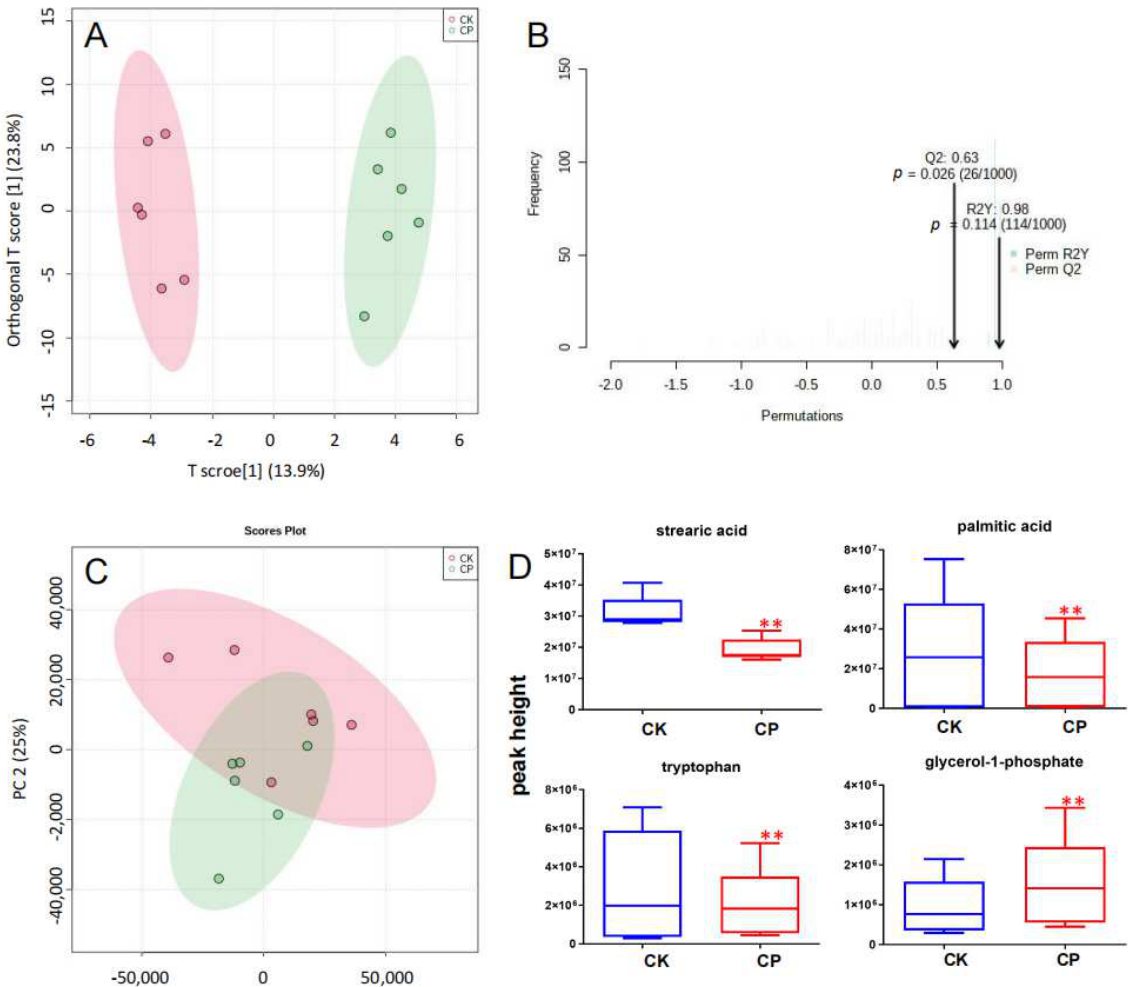
Figure 7. Metabolic profile and differential metabolites of polar substances in the amniotic fluid using GC-MS. ( A , B ) OPLS-DA score plots of the amniotic fluid metabolite profile and validation of OPLS-DA models with 1000 permutation tests ( n = 6). ( C ) PCA score plots of the amniotic fluid metabolite profile ( n = 6). ( D ) Normalized peak intensity of amniotic fluid metabolites differentially expressed in pregnant rats receiving CP ( n = 6). Each data point represents the mean ± S.E.M. ** p < 0.01 versus CK.